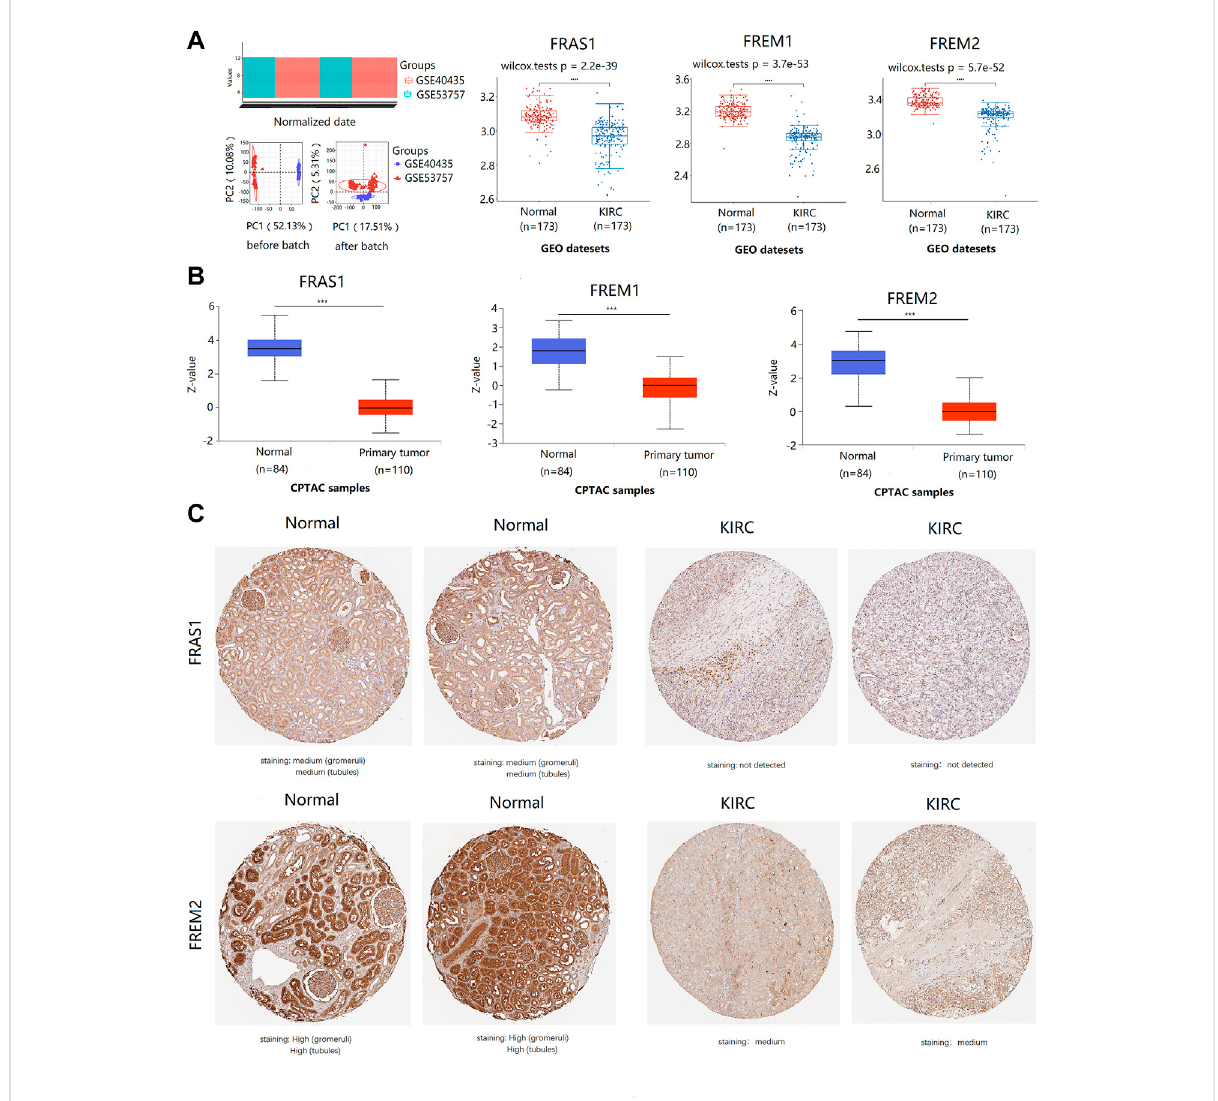
FIGURE 2 The expression pro fi leofFRAS1/FREMfamilymembersinKIRC tissues andnormalkidneytissues with datesetsfrom GEO andCPTACdatebase. (A) the expression pro fi le of FRAS1/FREM mRNA in KIRC samples and paired normal samples with datesets from the GEO database (GSE40435 and GSE53757) (**** p < 0.0001). (B) Protein expression of FRAS1/FREM in KIRC tissues and normal kidney tissues with datesets from CPTAC